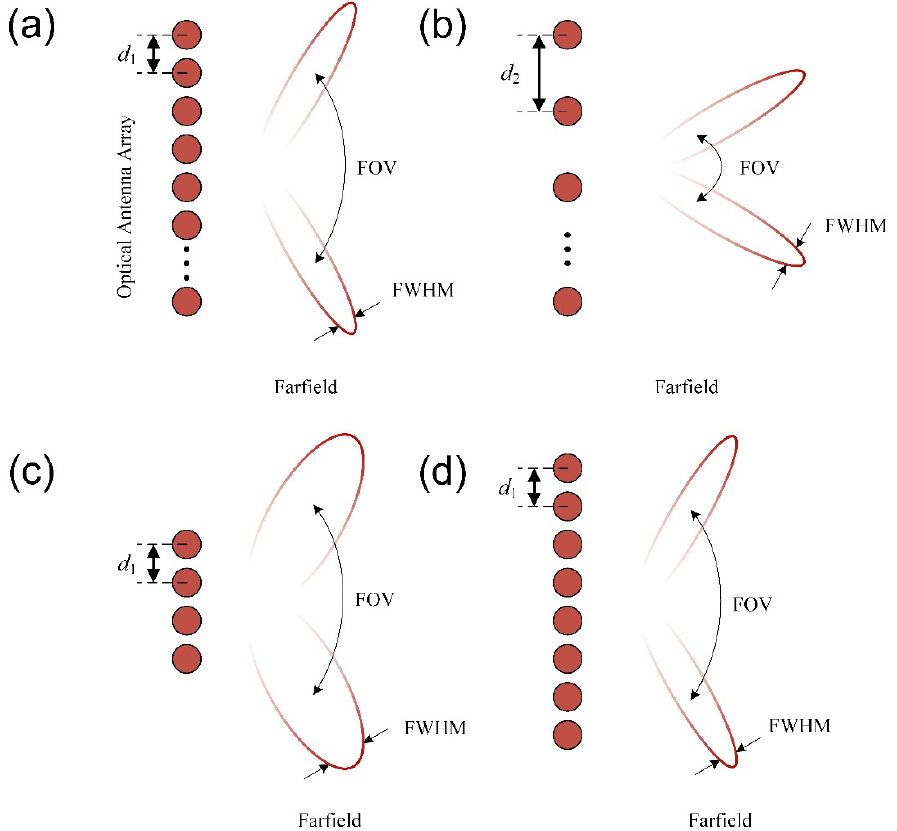
Figure 3. The schematic diagram of the far-field beam with ( a ) densely spaced antennas and ( b ) widely spaced antennas with the same antenna aperture; ( c ) small optical apertures, and ( d ) large optical apertures with the same antenna interval.